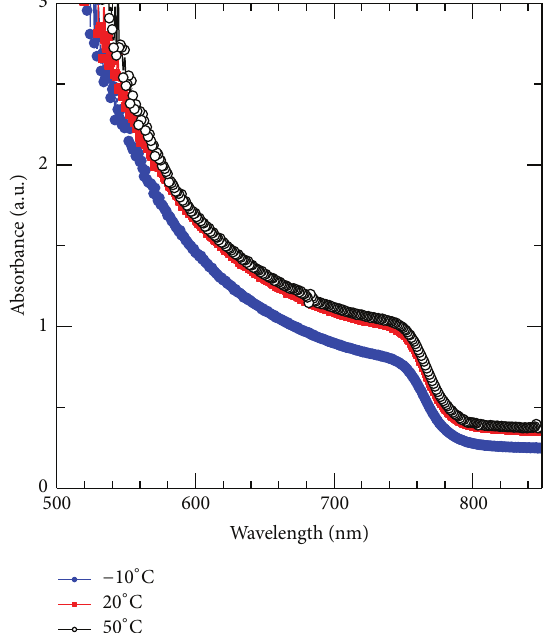
Figure 12: Absorbance spectra for − 10 ∘ C, 20 ∘ C, and 50 ∘ C. Repro- duced from [24] with permission from the Royal Society of Chem-